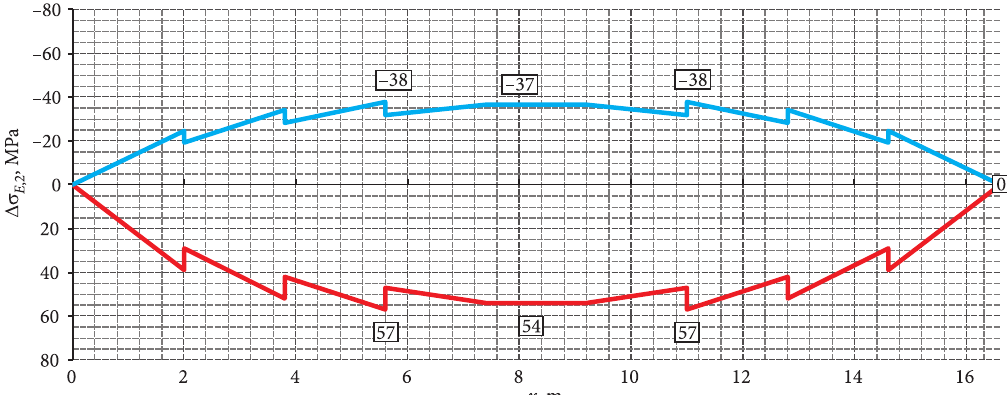
Fig. 12. Distribution of the normal stress range spectrum ∆ σ E ,2 for the main railway bridge girders